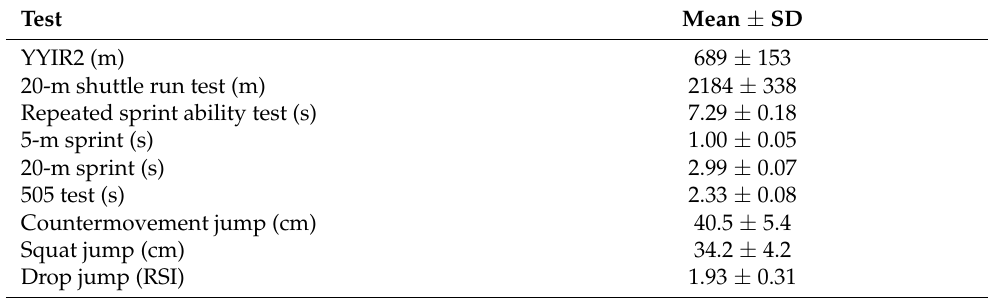
Table 1. The performance test results.